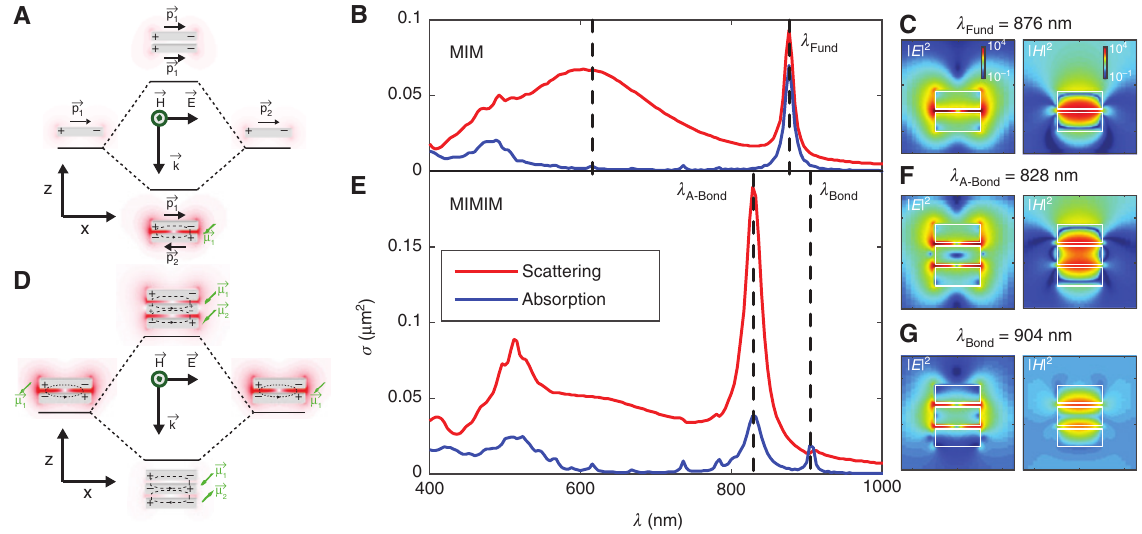
Figure 6: Multiresonant plasmonic systems based on the optical coupling between localized plasmonic modes in out-of-plane composite nanostructures [146, 147]. (A) The energy diagram, (B) the far-field scattering and absorption spectra, and (C) the near-field distribution maps of electric and